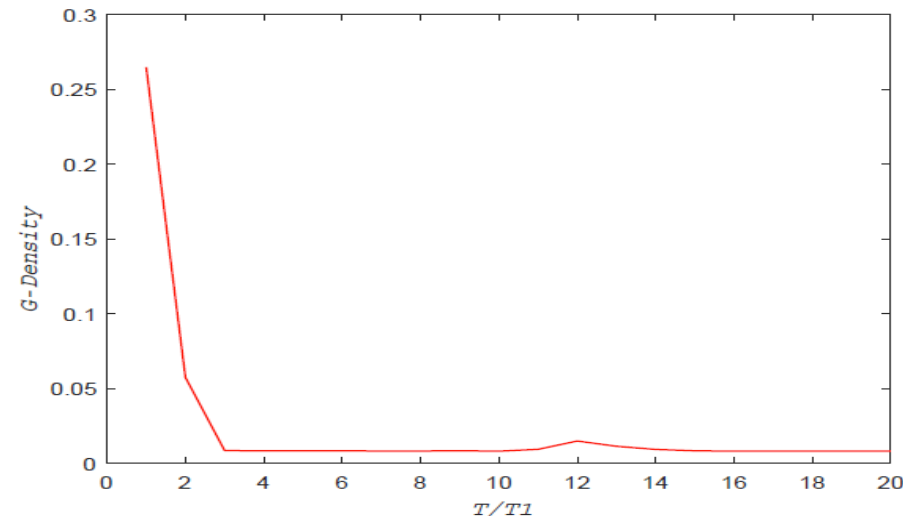
Figure 4. Evolution of global density in a collaborative innovation network.